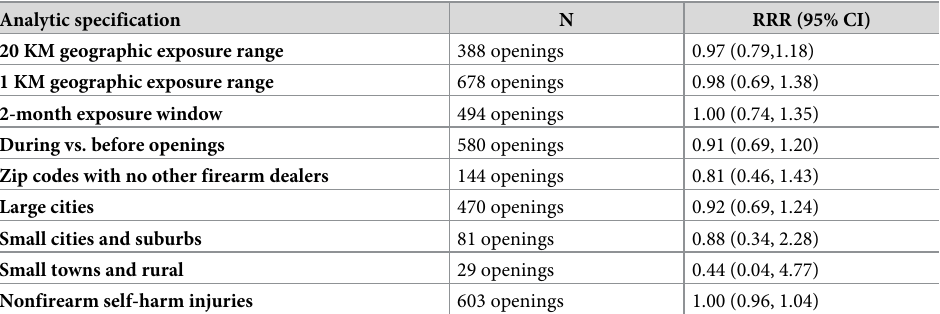
Table 4. Associations of firearm dealer openings with firearm self-harm for zip codes with no other firearm deal- ers, by urbanicity, for nonfirearm self-harm deaths and injuries, and for varied geographic ranges and durations of exposure.